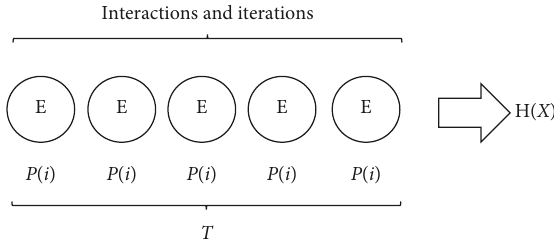
Figure 2: Consider a sequence of events i in which the execution of an activity E generates an X flow that results from the processing of information which can be processed with precision or imprecision, generating an entropy result dependent on the iterations and the interactions of the